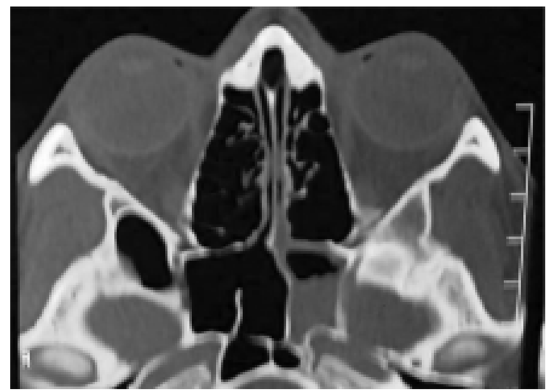
Fig. 6 Case 6. Left sphenoid sinusitis. CT scan axial view showing partial filling of the left sphenoid sinus without bone destruction or bone